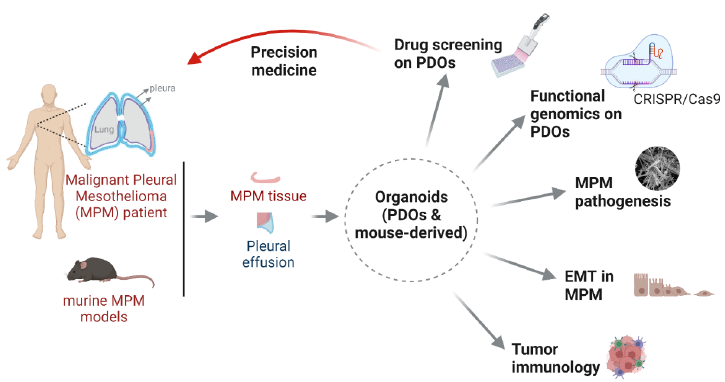
Figure 1. Patient-derived organoids as model of precision medicine for MPM.